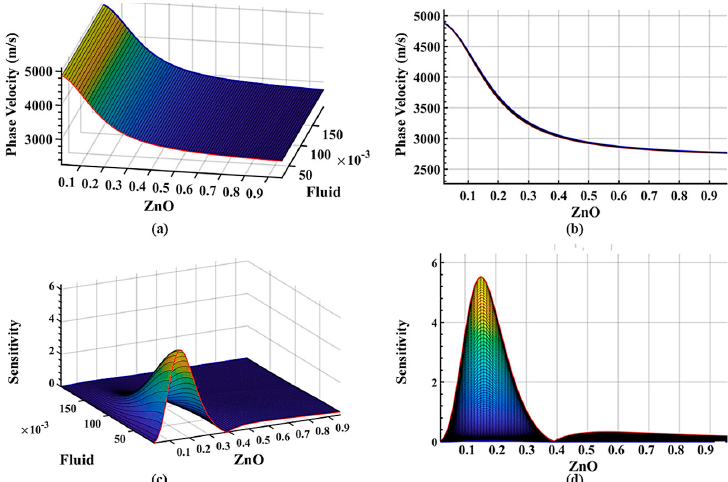
Figure 4. Dispersion surface plots of the four-layer system with a varying thickness of the liquid layer at 100 MHz with relaxation time, ωτ = 10. The thickness of the second guided layer IrO 2 is set to 35 nm with a constant viscosity of 20 cP. ( a ) Isometric view of the phase velocity dispersion with varying thickness of the liquid layer; ( b ) phase velocity vs. ZnO thickness variation; ( c ) isometric view of the mass sensitivity (unit: m 2 /kg) dispersion with varying thickness of the liquid layer; ( d ) sensitivity (unit: m 2 /kg) vs. ZnO layer thickness variation.